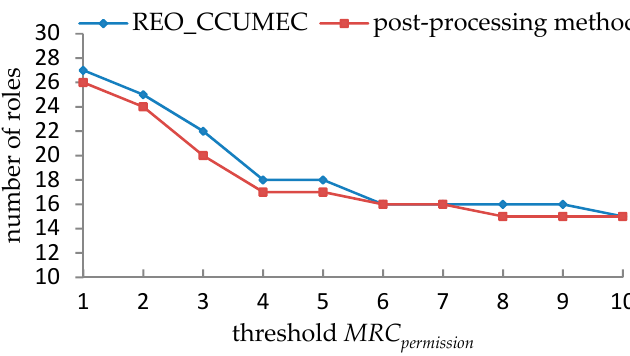
Figure 5. Performance comparison under the PCC in Domino.